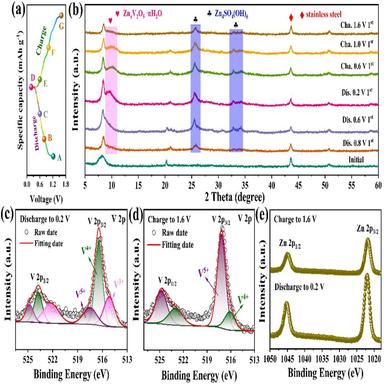
(a) The GCD curves of VO-5 at 1 A g− 1 . (b) Ex situ XRD spectra at various voltage states in (a). (c) Ex situ XPS spectra of V 2p at discharged to 0.2 V, (d) charged to 1.6 V, and (e) Zn 2p states in the 1st cycle.